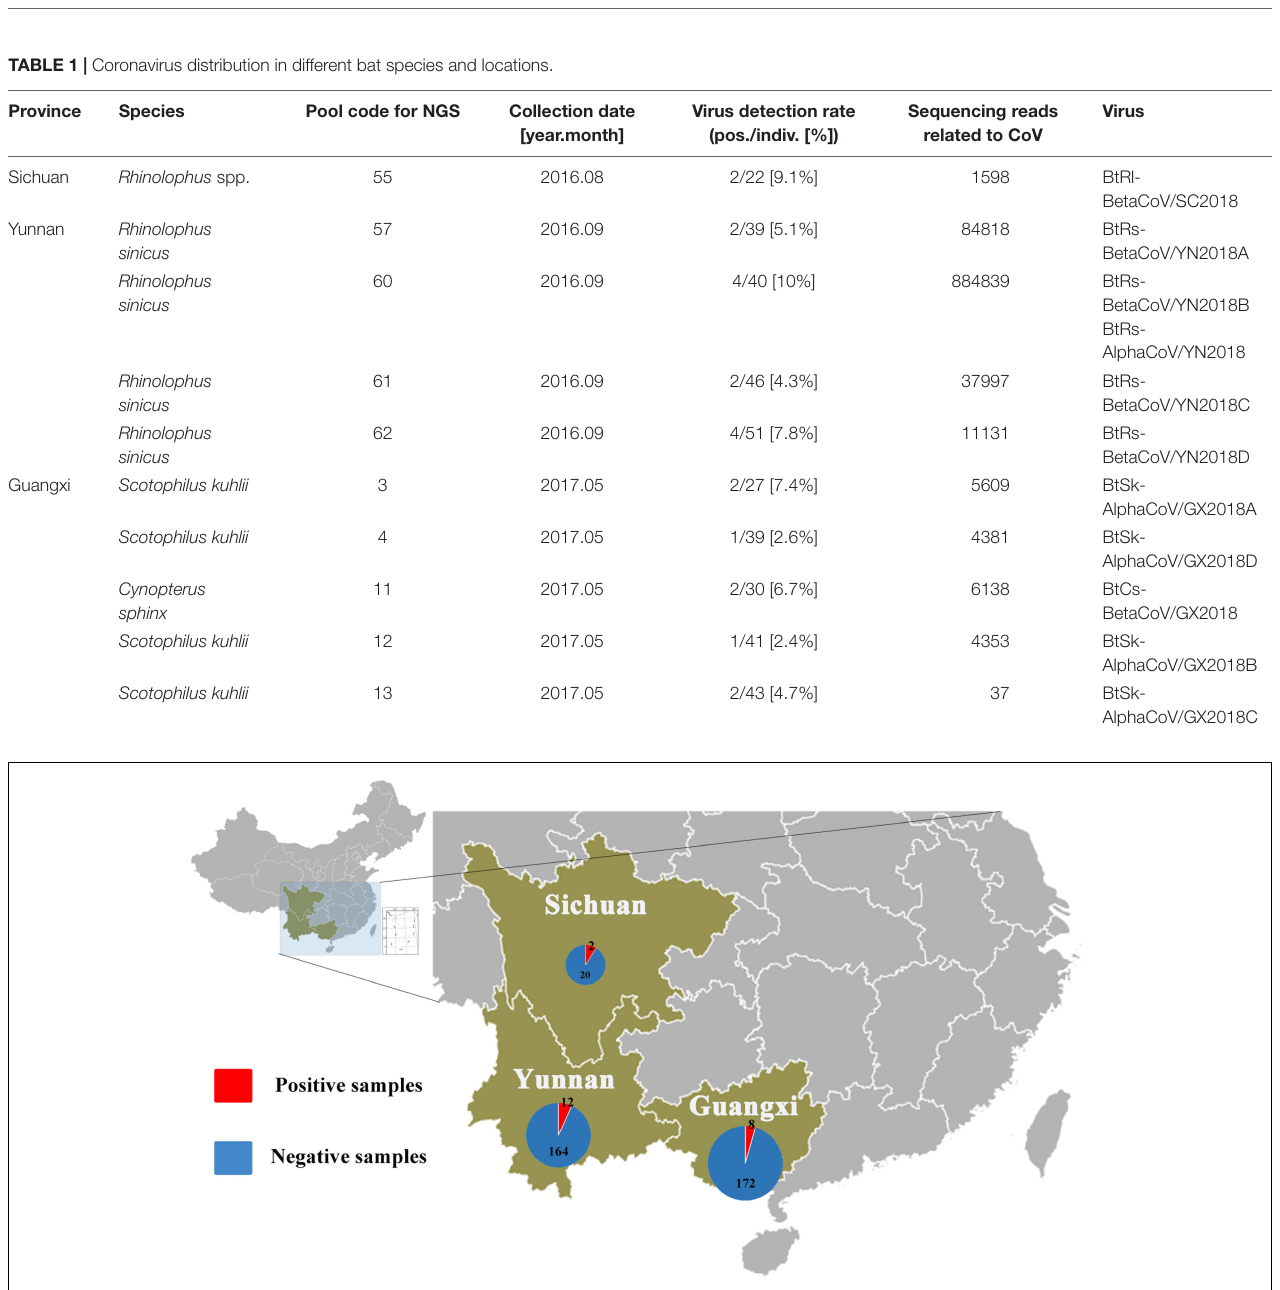
β -YN2018 (A–D) were mainly present in ORFs-e and ORFm- n regions. We named these accessory ORFs according to previous